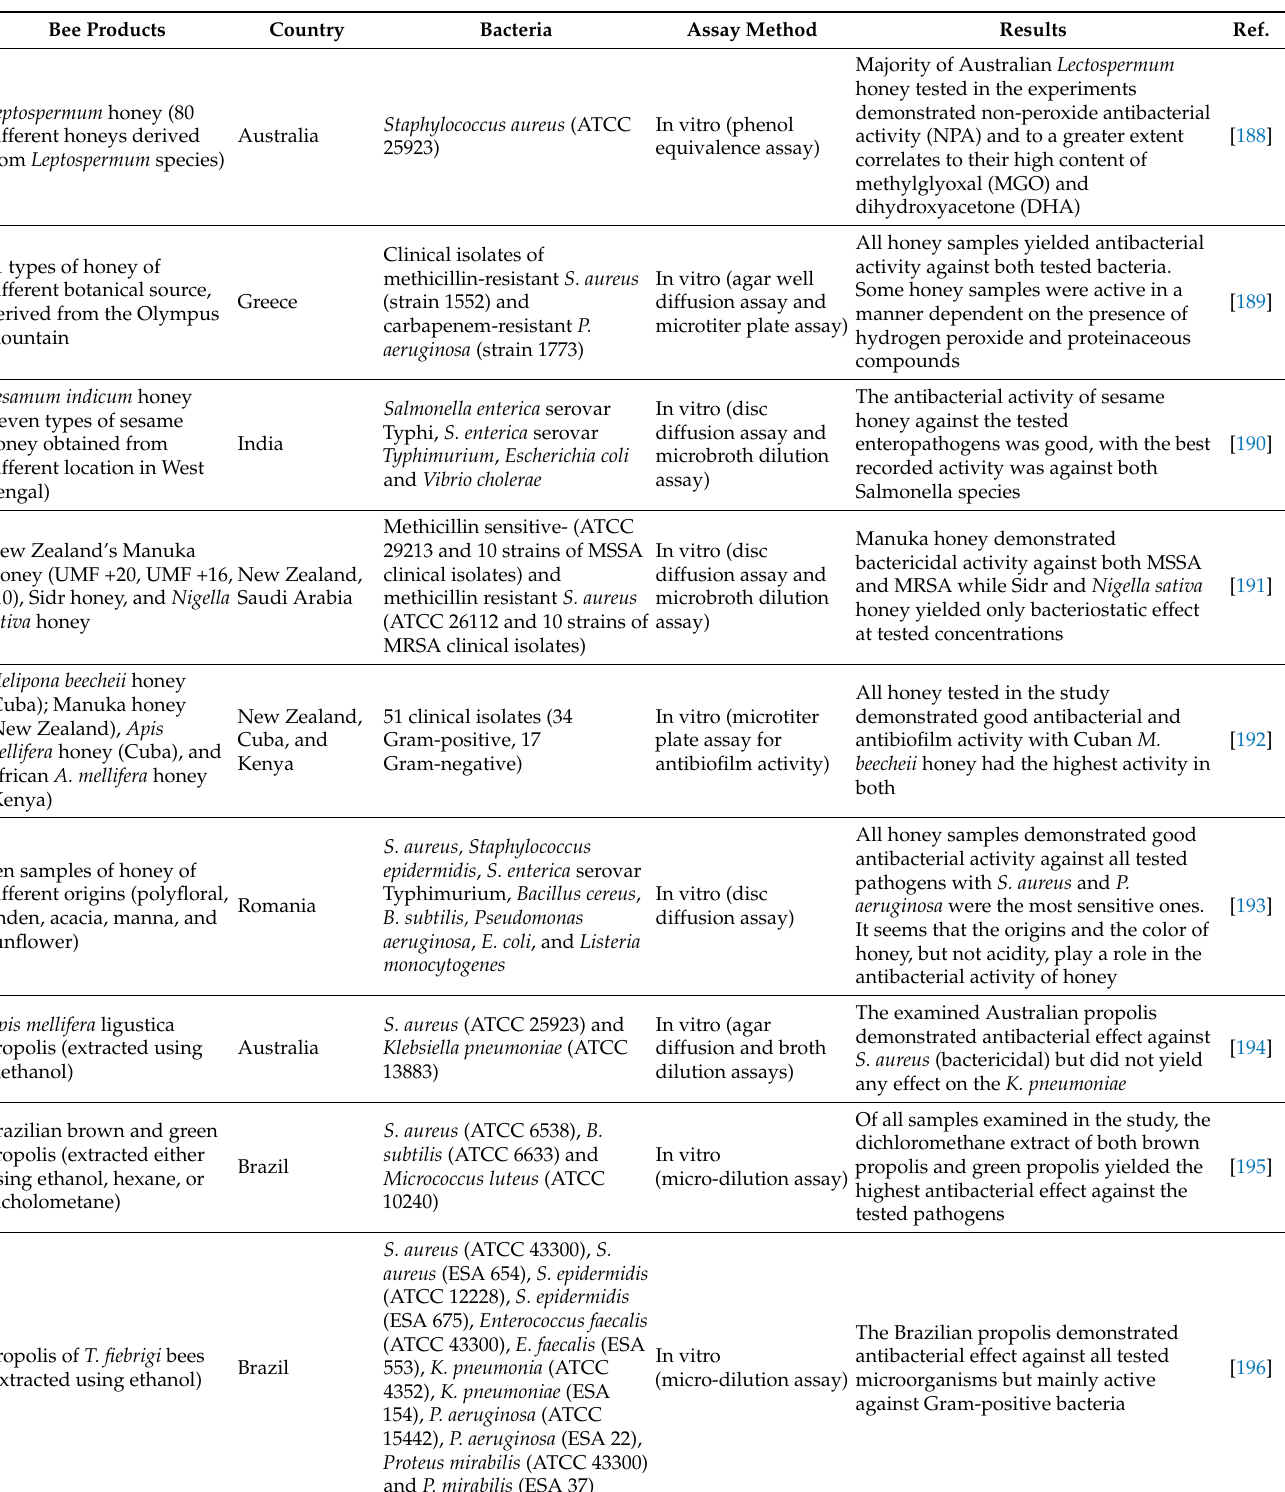
Table 2. Antibacterial activity of selected bee